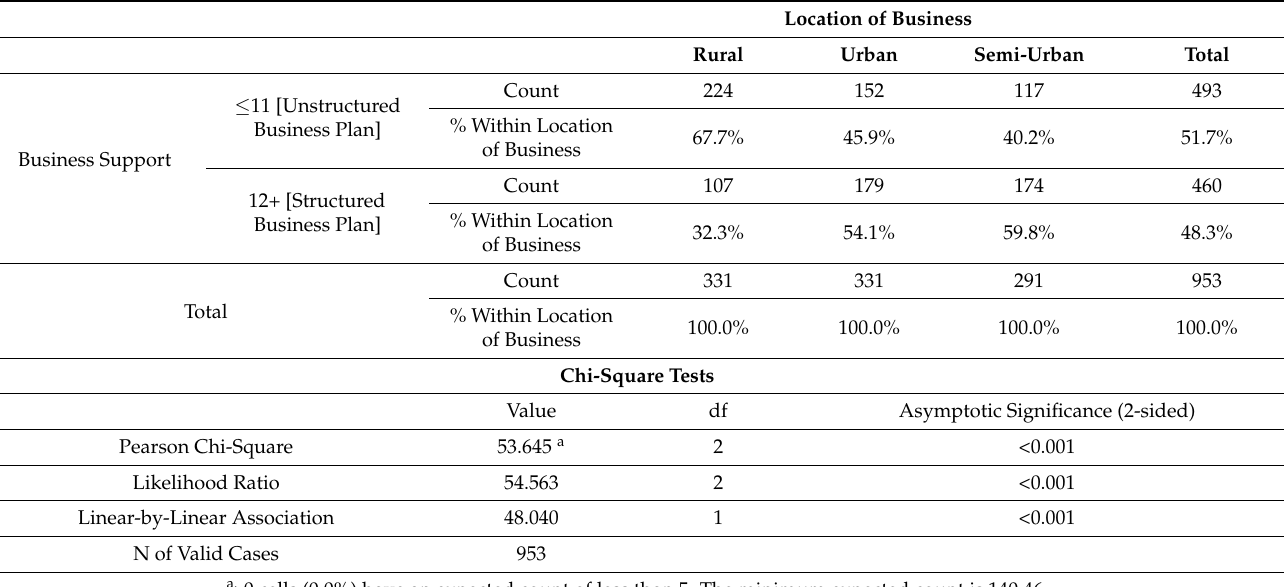
Table 4. Business plan score * location of